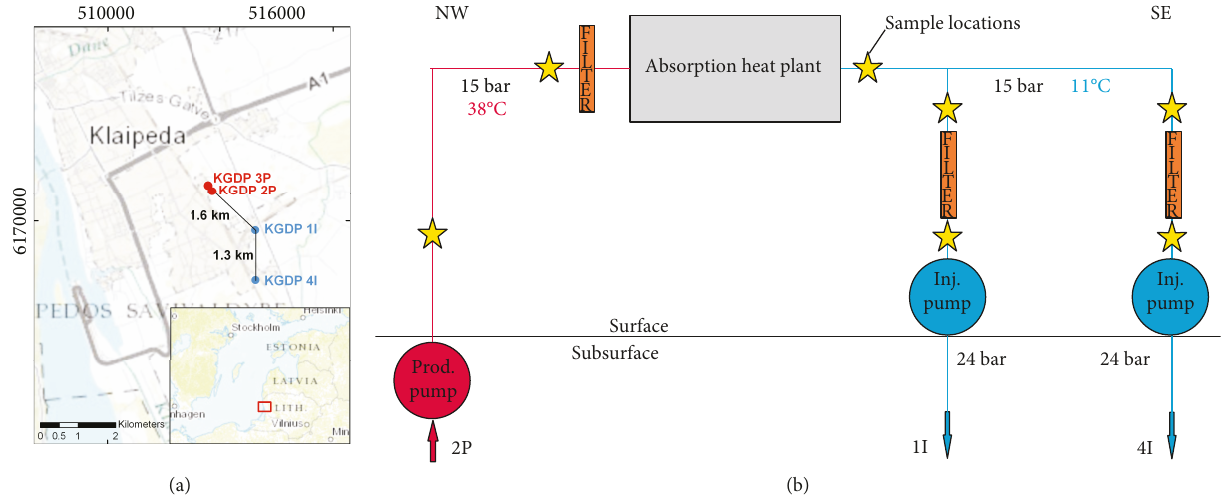
Figure 1: Location (a) and setup (b) of the Klaipeda geothermal demonstration plant. Including operational parameters of the plant and sample locations (yellow